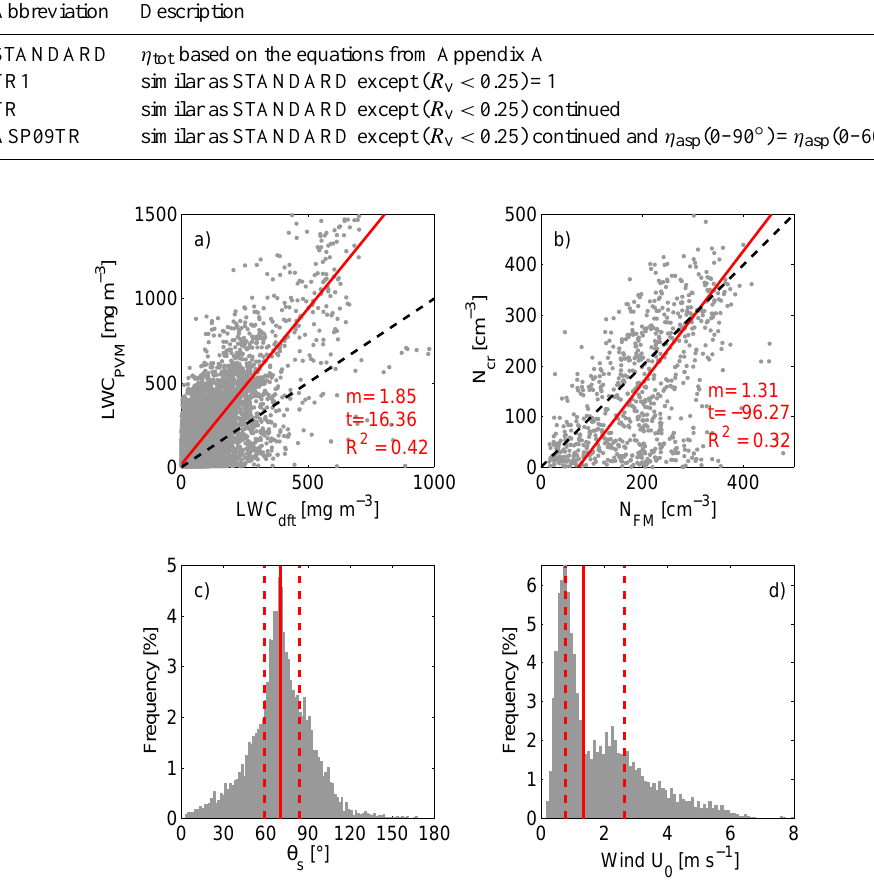
Fig. 9. Overview of the measured data during CLACE 2010. (a) Liquid water content measured by the PVM-100 (LWC PVM ) versus the FM-100 measurements using the default channel configuration (LWC dft ); (b) number concentrations of cloud residuals ( N cr ) versus cloud droplet number concentration measured by the FM-100 ( N FM ). The solid red line in (a) and (b) represents a geometric mean regression with m : slope, t : intercept and R 2 : squared correlation coefficient. (c) Frequency of observed sampling angle θ s ; (d) frequency of observed horizontal wind speed U 0 . Both parameters were determined by ultrasonic measurements. The solid red line represents the median, while the dashed lines show the 25th and 75th percentile,